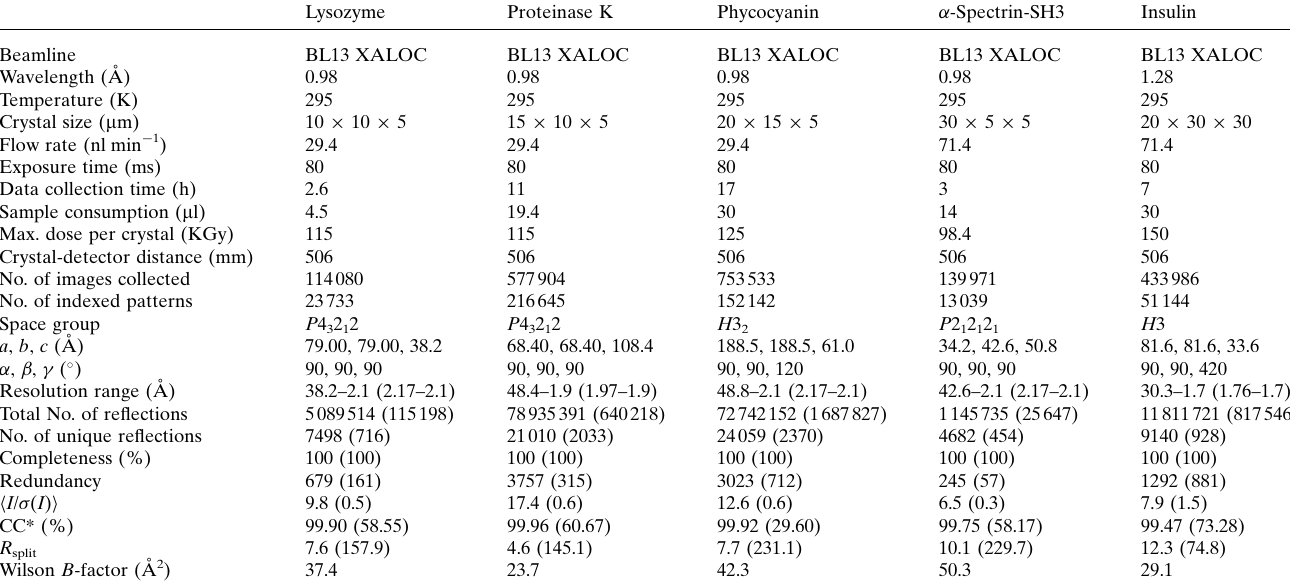
Table 1 Data collection statistics (values in parentheses are for the high-resolution